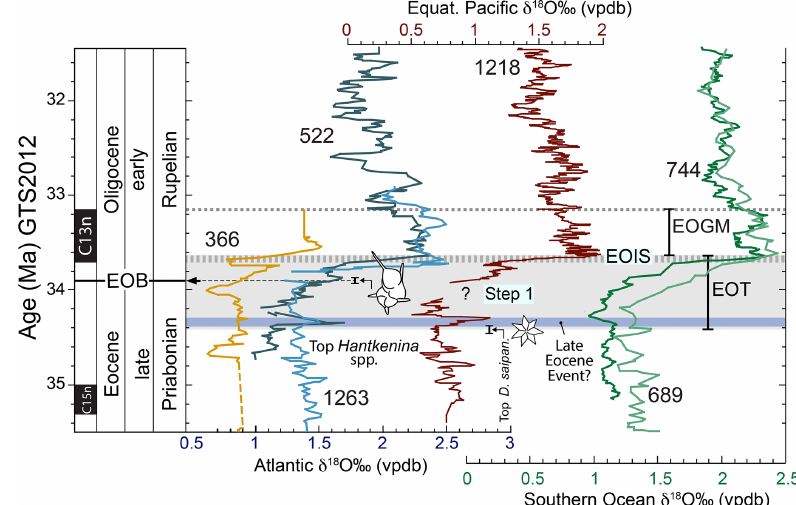
Figure 1. Oxygen stable isotope and chronostratigraphic characteristics of the Eocene–Oligocene transition (EOT) from deep marine records and EOT terminology on the GTS2012 timescale. Benthic foraminiferal δ 18 O from six deep-sea drill holes are shown: tropical Atlantic Site 366, South Atlantic sites 522 and 1263 (Zachos et al., 1996; Langton et al., 2016); Southern Ocean sites 744 and 689 (Zachos et al., 1996; Diester-Haass and Zahn, 1996) and equatorial Pacific Site 1218 (Coxall and Wilson 2011). Due to different sample resolutions, running means are applied using a three-point filter for sites 522, 689 and 1263; five-point filter for sites 366 and 744; and a seven-point filter for Site 1218. Timescale conversions were made by aligning common magnetostratigraphic tie points. The EOT is defined as a ca. 790kyr long phase of accelerated climatic and biotic change that began before and ended after the Eocene–Oligocene boundary (EOB) (after Coxall and Pearson, 2007). It is bounded at the base by the “top” D. saipanensis nannofossil extinction event and above by the EOIS- δ 18 O maximum. Benthic data are all Cibicidoides spp. or “ Cibs. equivalent” and have not been adjusted to seawater equilibrium values. “Step 1” comprises a modest δ 18 O increase linked to ocean cooling (Lear et al., 2008; Bohaty et al., 2012). The “top Hantkenina spp.” marker corresponds to the position of this extinction event at DSDP Site 522 (including sampling bracket) with respect to the corresponding Site 522 δ 18 O curve. That it coincides with the published calibrated age of this event (33.9Myr) is entirely independent. The “late Eocene event” δ 18 O maximum (after Katz et al., 2008) may represent a failed